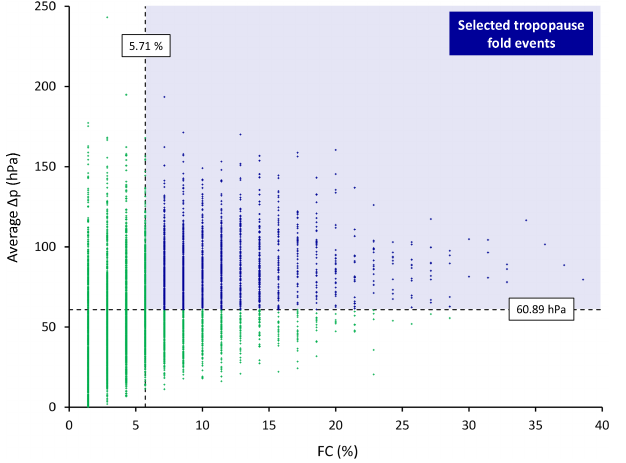
Figure 3. Scatter plot distributions of FC and average (cid:49)p for the summer time steps of the period 1979–2013 over the domain of interest (box in Fig.